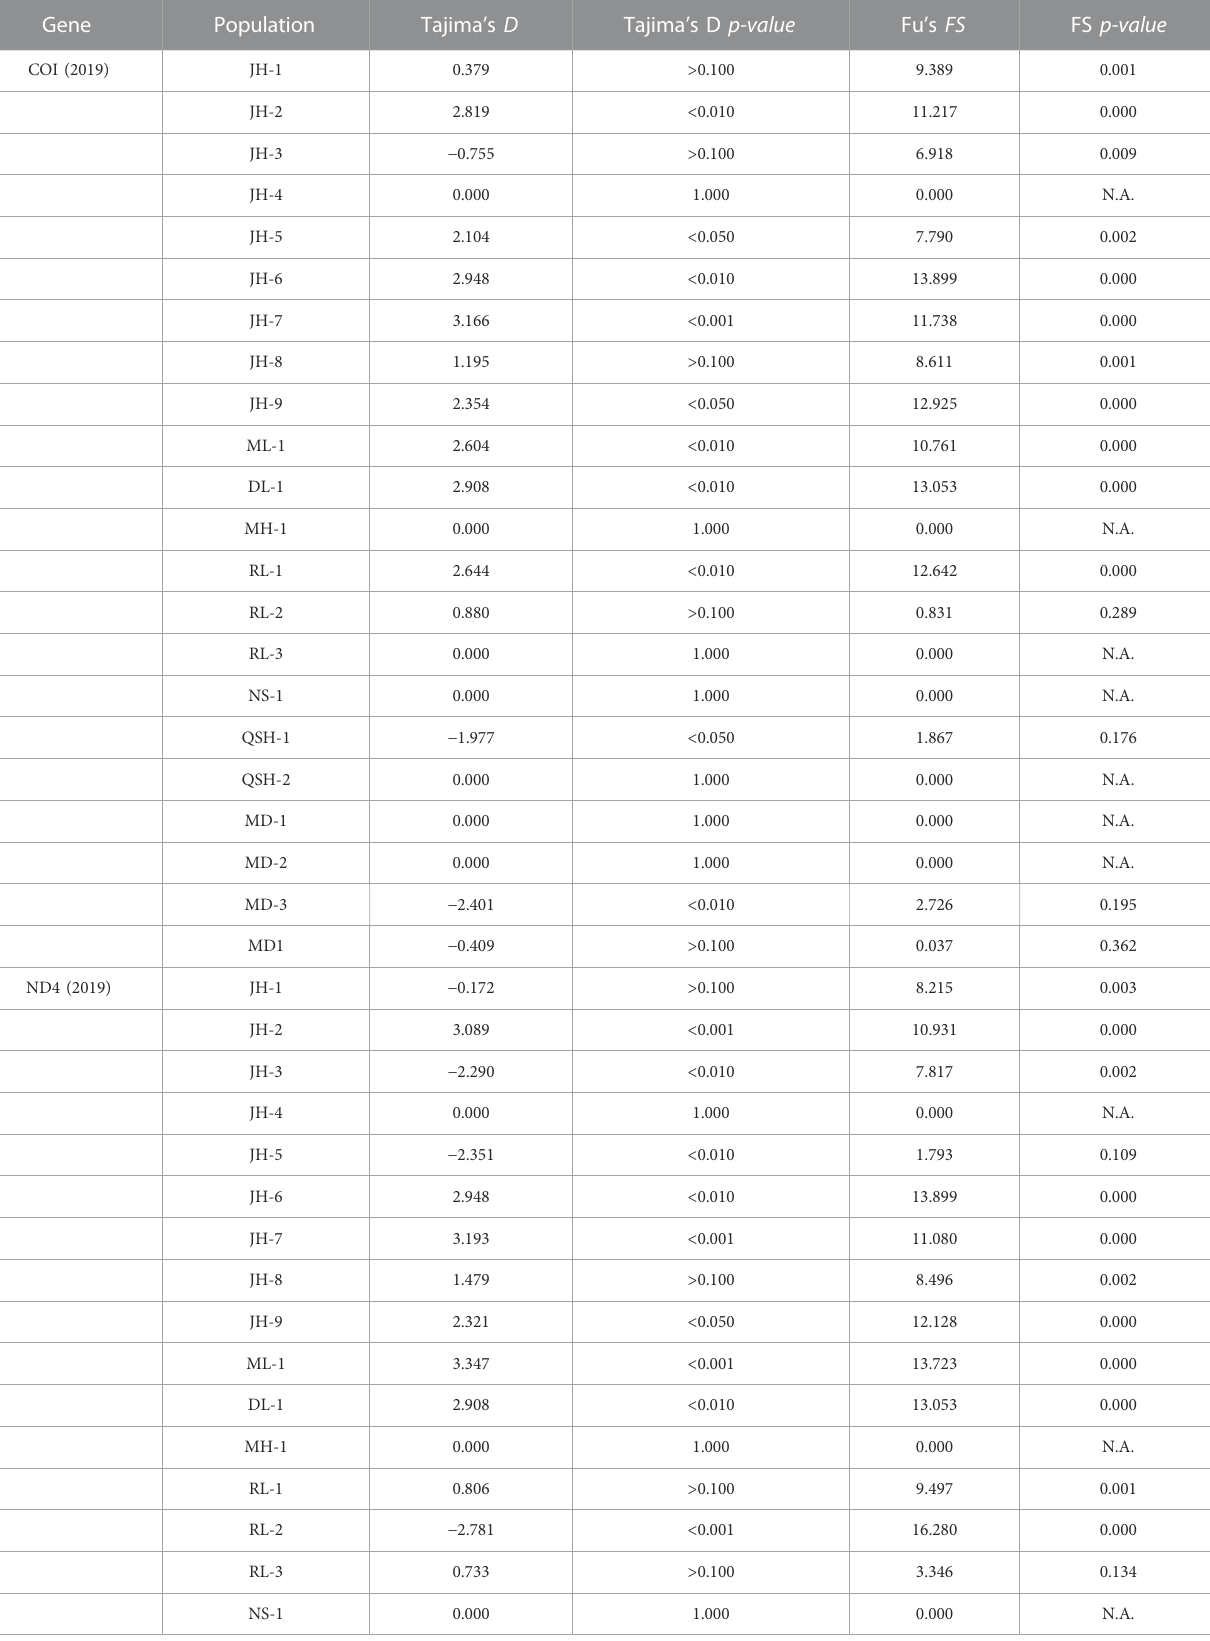
TABLE 7 Neutrality test of 22 populations and 17 populations based on mtDNA in 2019, 2020.